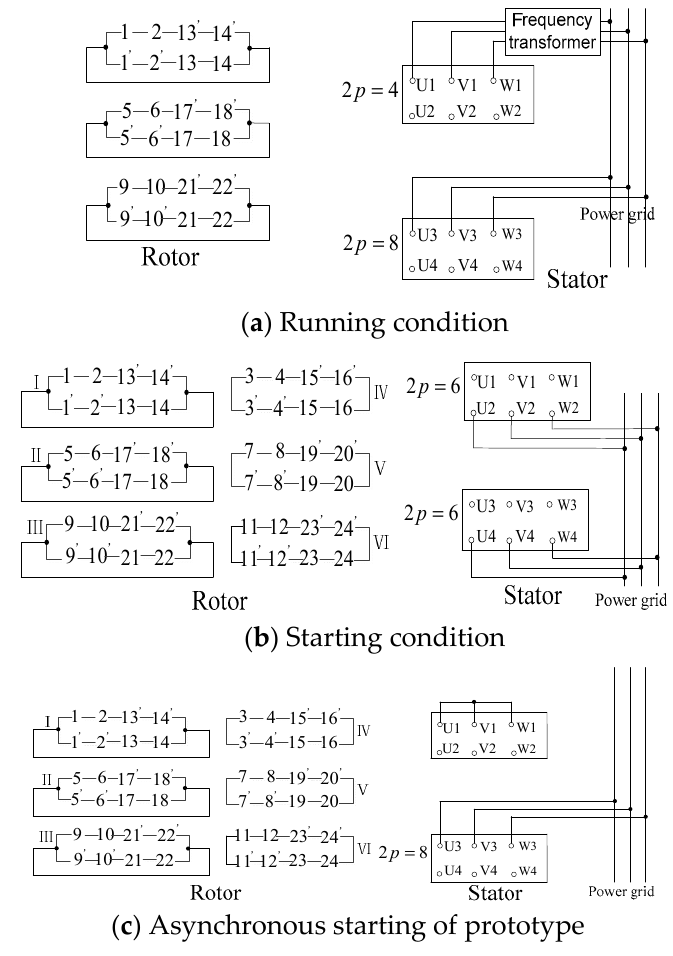
( c ) Asynchronous starting of prototype Figure 9. Stator and rotor winding wiring diagram under different working conditions. Figure 9. Stator and rotor winding wiring diagram under different working